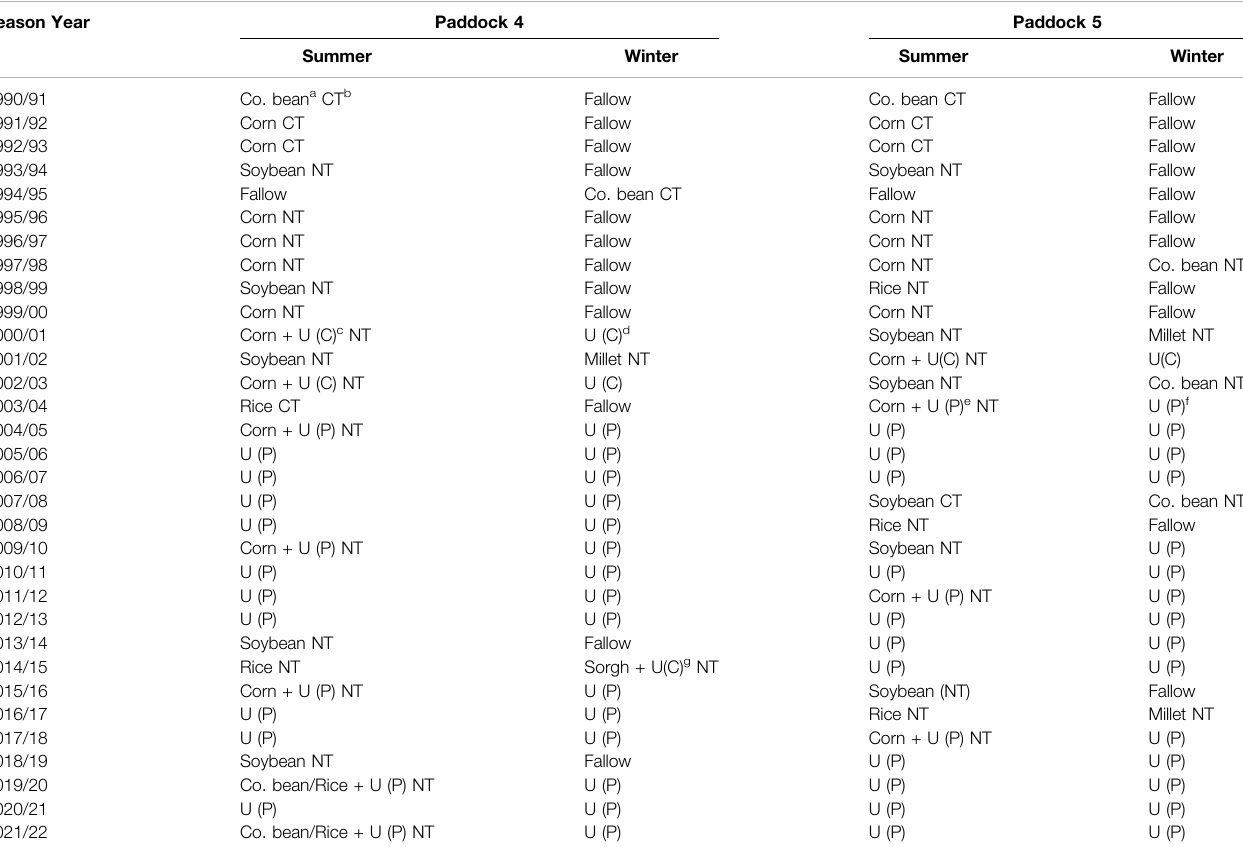
TABLE 1 | Cropping sequences and tillage history of the two paddocks (4 and 5) under integrated crop-livestock systems at Santo Antônio de Goiás, Goiás State, Brazil (1990 –